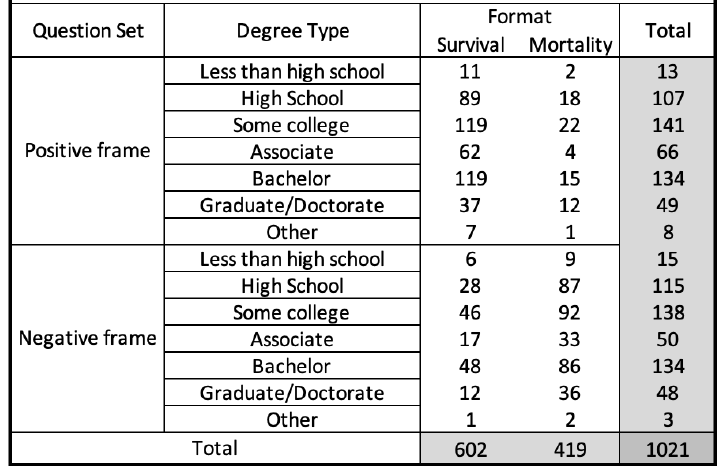
Figure 7. Respondent totals by education level.